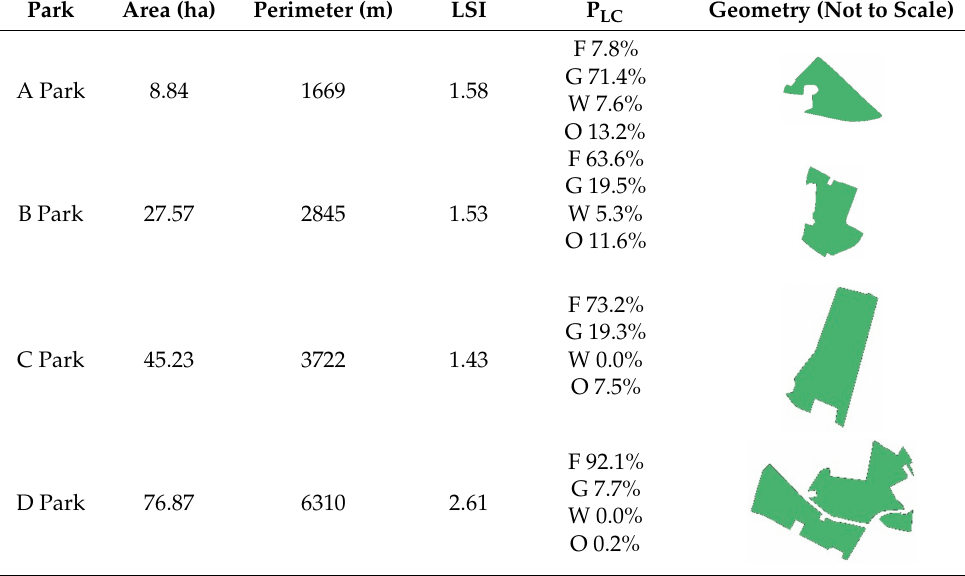
Figure 3. Distribution of urban parks for the city of Wroclaw according to their size. The first two (grey) points denote Park A. Table 2. Urban park